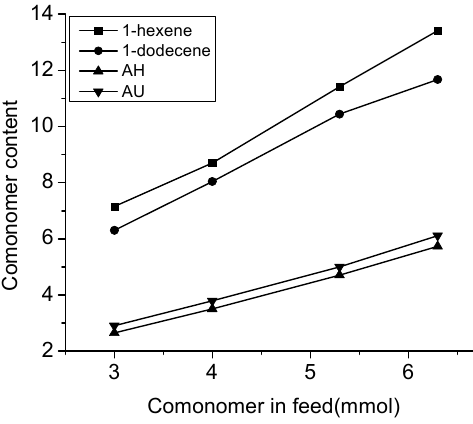
Figure 2. Plots of comonomer content against the comonomer concentration in feed.